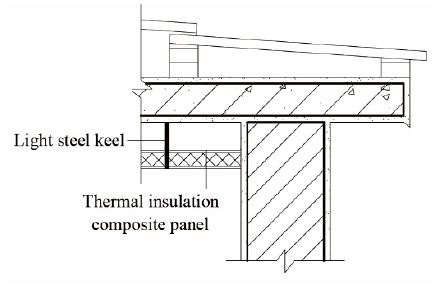
Figure 29. Indoor insulation ceiling.